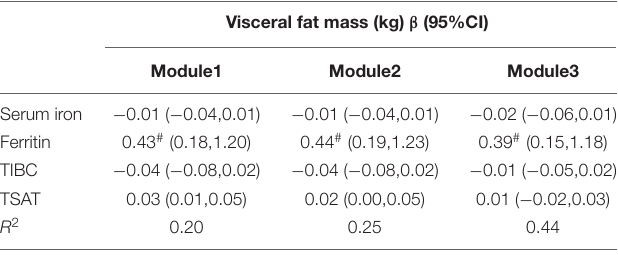
Model 1: Unadjusted. Model 2: Model 1 additionally adjusted for age and gender. Model 3: Model 2 additionally adjusted for BMI, hs-CRP, total body fat, and waist circumference. # Indicates to p <